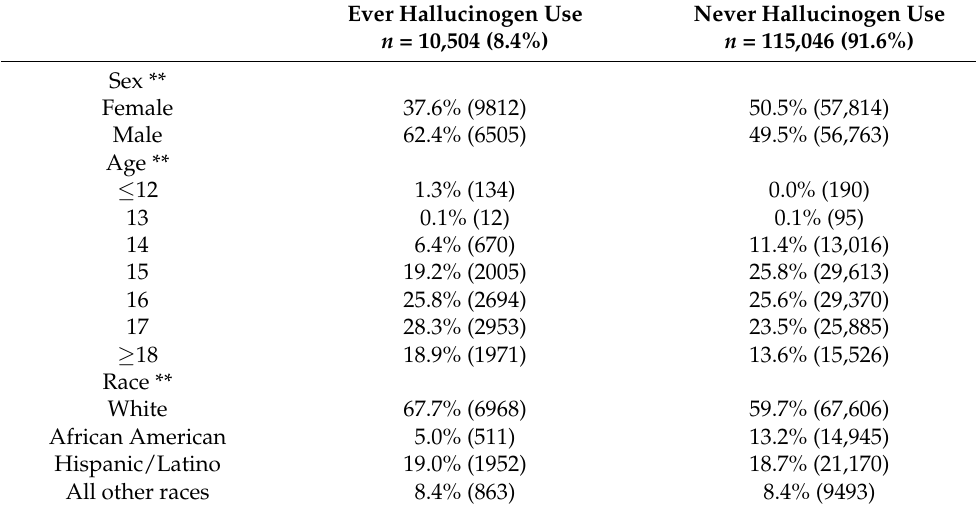
Table 1. Epidemiological characteristics of school-going US adolescents—YRBSS 2001–2019.